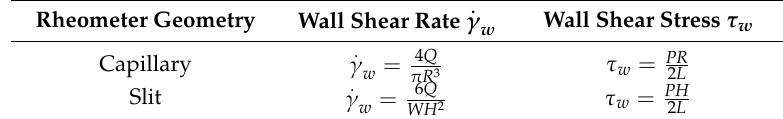
Table 1. Pressure-driven viscometers formulae. Q is the volumetric flow rate, P is the pressure drop, L is the capillary or slit length, R is the capillary radius, W is the slit width, and H is the slit